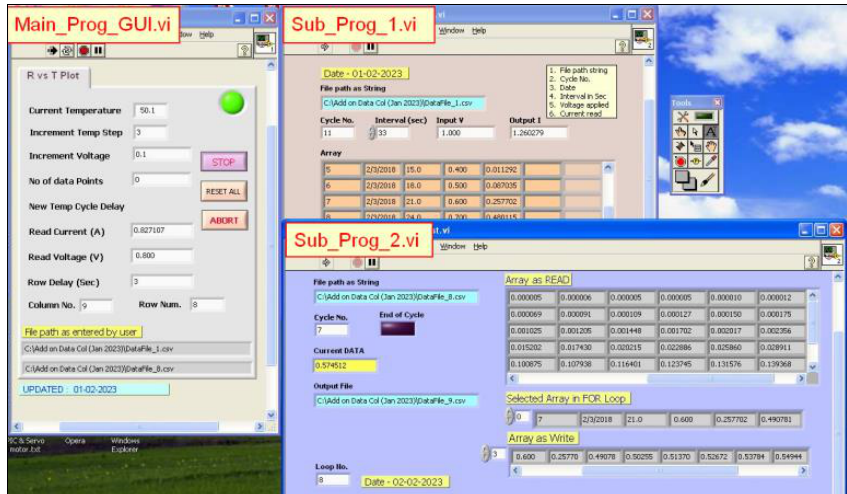
Figure 1: Screenshot of three graphical interface files among them, Main_Prog_GUI.vi control the parameters, and the other two display the data while acquisition is in